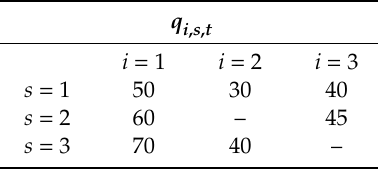
Table A28. Minimum quantity for purchase discounts (units) (considered here the same for any time